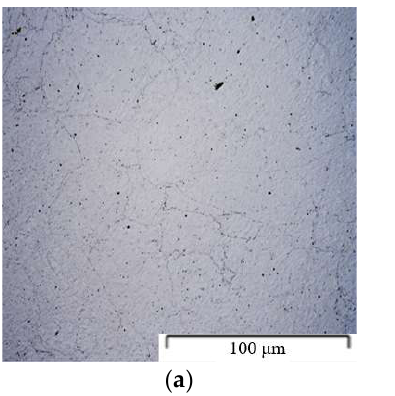
Figure 6. Materials compacted by SPS (OM): ( a ) Zn-1Mg (1200 RPM, 60 min), ( b ) Zn-6Mg (1200 RPM, 60 min), ( c ) Zn-16Mg (1200 RPM, 60 min).